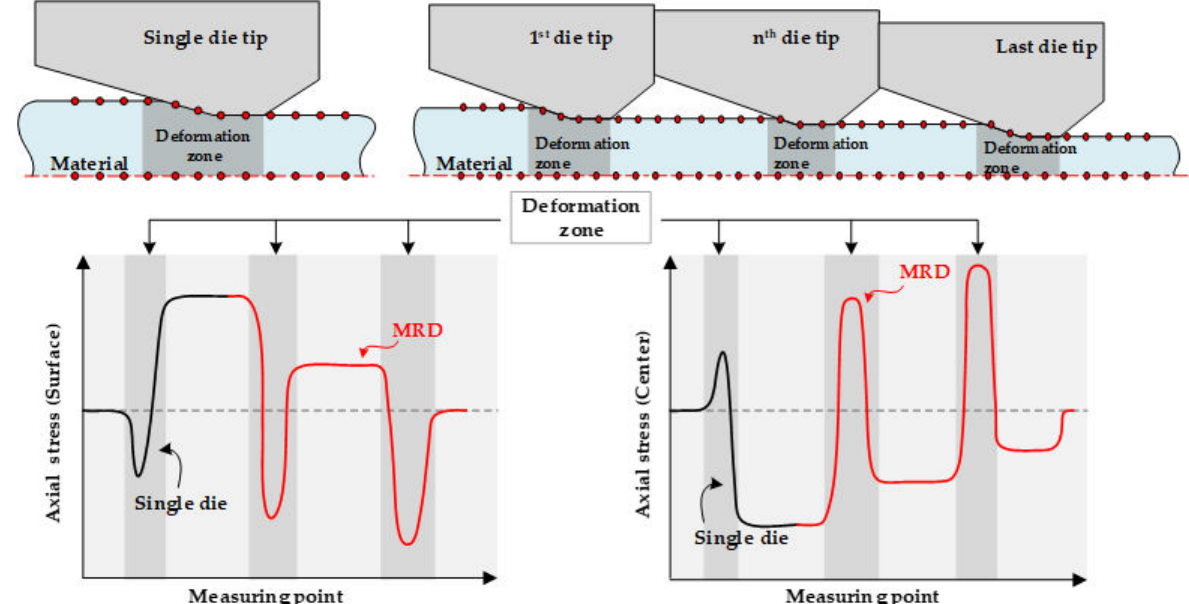
Figure 2. Schematic illustration of axial stress in the drawing process with